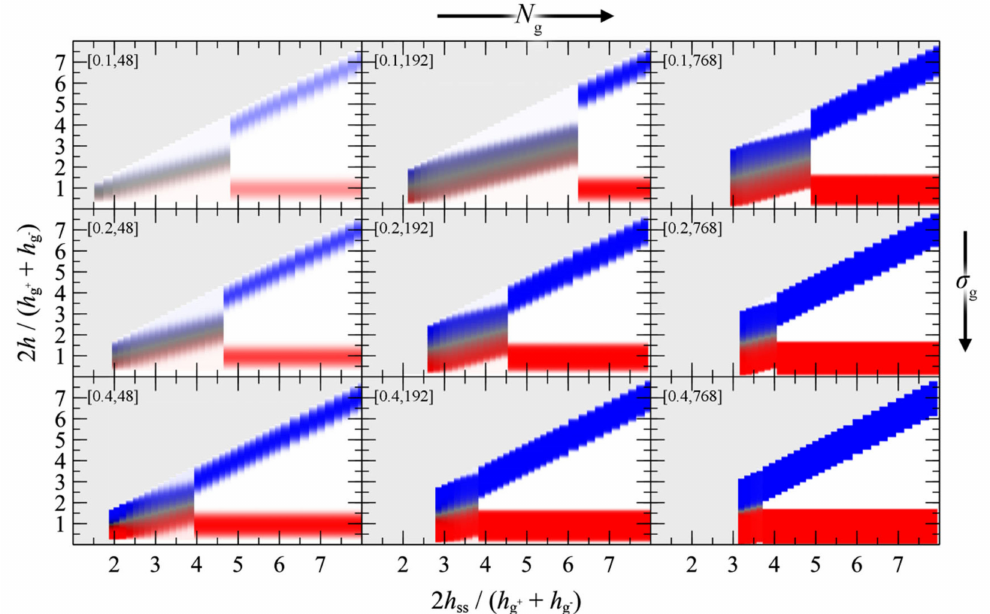
Figure 14. Reduced density distributions corresponding to the PMF GVG panels in Figure 13, as functions of the plate-plate distance (abscissa) and the distance from the left wall (ordinate) in reduced units. Red/blue colors correspond to regions with high density ( ϕ c = 1) of c = g – , g + chains. White corresponds to vacuum. Grey denotes regions which lie outside the modeled domain or have not been evaluated at all. Labels in brackets denote σ g (nm − 2 ) and N g